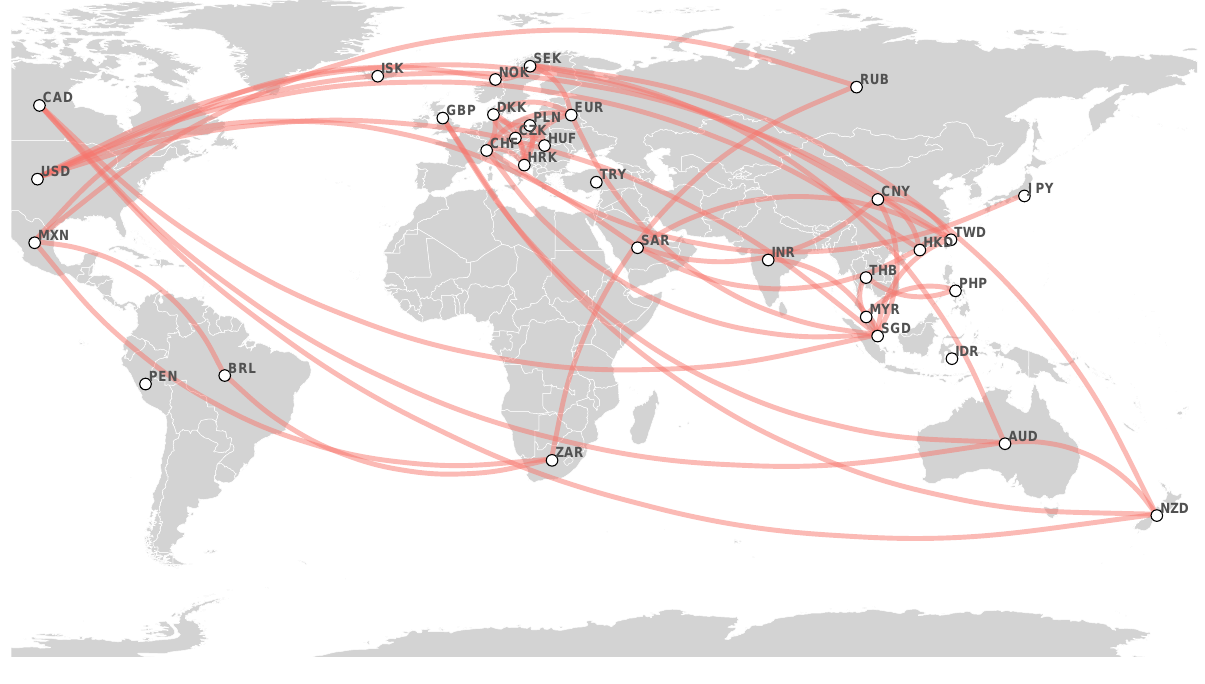
gray Figure 8. Estimated currency network based on 2020 foreign exchange markets data.